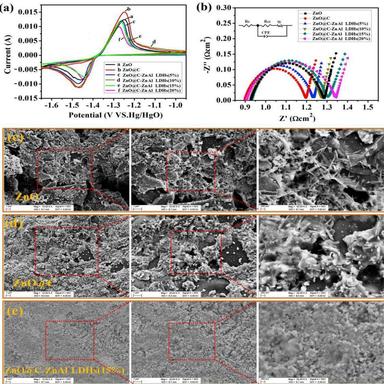
(a) Cyclic voltammograms of the ZnO, ZnO@C, ZnO@C-ZnAl LDHs composites electrodes at a scan rate of 10 mV s−1; (b) Nyquist plots of the ZnO, ZnO@C, ZnO@C-ZnAl LDHs composites electrodes; Ex-situ FE-SEM images of the ZnO (a), ZnO@C(b), and ZnO@C-ZnAl LDHs(15%) composite (c) electrodes in the discharged state after 200th charge-discharge cycles at different magnifications.